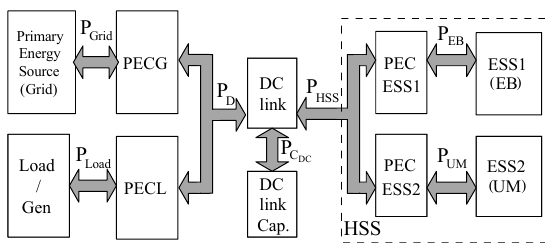
Figure 1. Scheme of the power flow balance in a general Hybrid Storage System